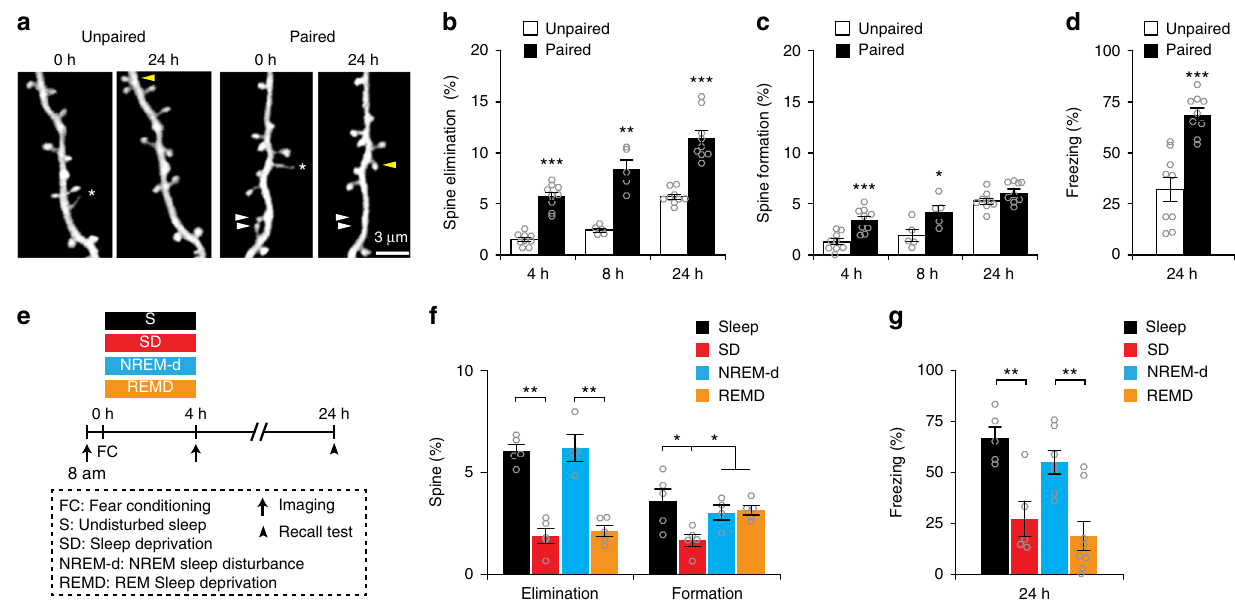
Fig. 3 SD or REMD reduces FC-induced spine elimination in FrA. a Repeated imaging of dendritic spines on the apical tuft dendrites of layer 5 pyramidal neurons in FrA in paired and unpaired mice. White and yellow arrowheads indicate eliminated and formed spines respectively; asterisks indicate fi lopodia. Scale bar: 3 μ m. b Dendritic spine elimination was signi fi cantly higher in the paired group than unpaired group over 4 – 24 h ( n = 9 mice at 4 h, 24 h for each group and n = 5 mice at 8 h for each group; P < 0.0001, = 0.0079 and < 0.0001 for 4, 8, and 24 h, respectively, Wilcoxon – Mann – Whitney test, two-sided). c Dendritic spine formation was signi fi cantly higher in the paired group than unpaired group within 8 h, but not over 24 h ( n = 9 mice at 4 h, 24 h for each group and n = 5 mice at 8 h for each group; P = 0.0006, = 0.0317 and = 0.0814 for 4, 8, and 24 h, respectively, Wilcoxon – Mann – Whitney test, two- sided). d Freezing response test 24 h after FC ( n = 9 mice for each group; P < 0.0001, Wilcoxon – Mann – Whitney test, two-sided). e Schematic of experimental design to assess the effect of sleep or REM sleep. f FC-induced dendritic spine elimination was signi fi cantly reduced after 4-h SD or REMD, while spine formation was signi fi cantly reduced only after 4-h SD (Sleep, SD and REMD: n = 5 mice for each group, NREM-d: n = 4 mice, P = 0.0036 for elimination and P = 0.021 for formation, Kruskal – Wallis test followed by multiple comparisons test). g SD or REMD signi fi cantly reduced freezing response 24 h after FC (SD and Sleep: n = 5 mice for each group; REMD: n = 8 mice, NREM-d: n = 7 mice, P = 0.0024, Kruskal – Wallis test followed by multiple comparisons test). * P < 0.05, ** P < 0.01, *** P < 0.001. Data are presented as mean ± s.e.m. Source data for ( b – d ), ( f ) and ( g ) are provided as a Source Data fi